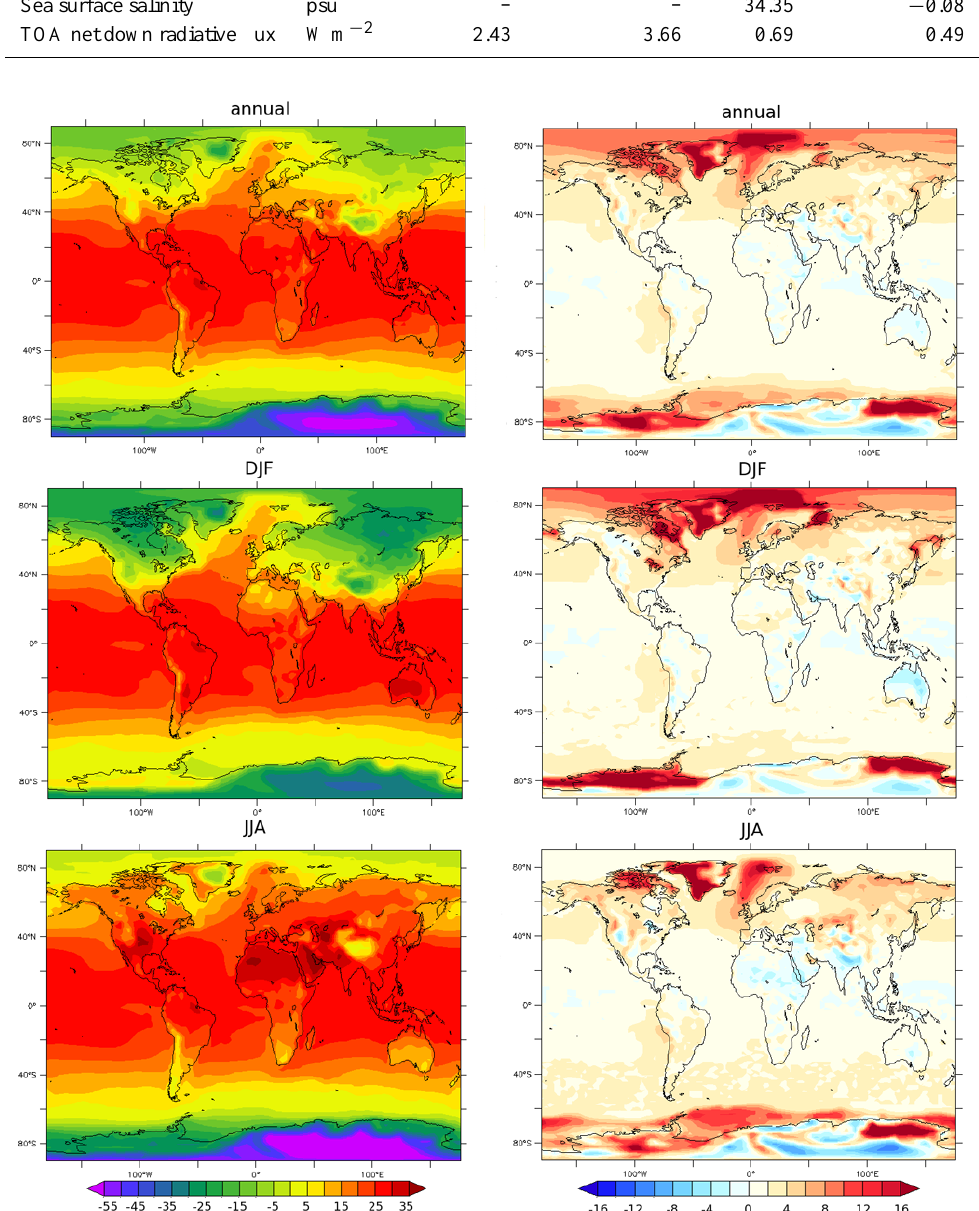
Fig. 8. AGCM mid-Pliocene (Plio1 alt) mean surface temperatures (left) for yearly average, December-January-February, June-July-August, and their anomaly to the control (right), expressed in degrees